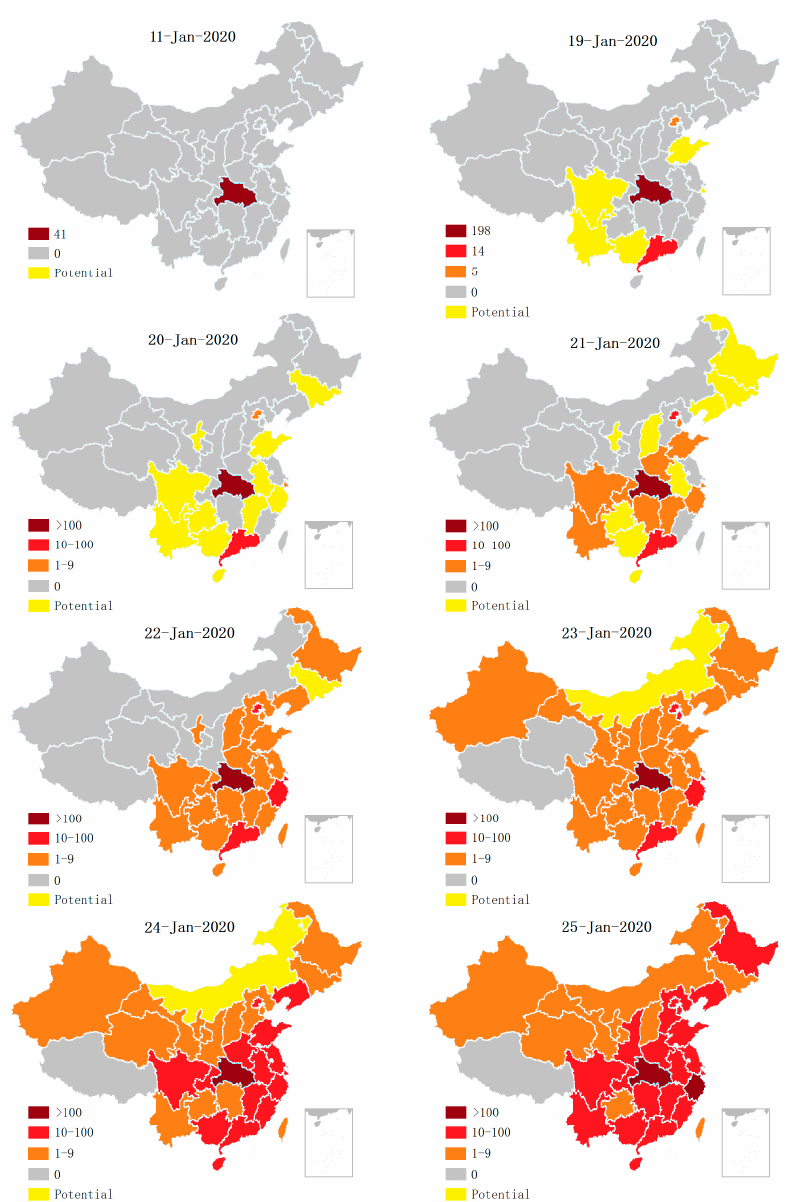
Figure 2. Spatiotemporal distribution of COVID-19-infected